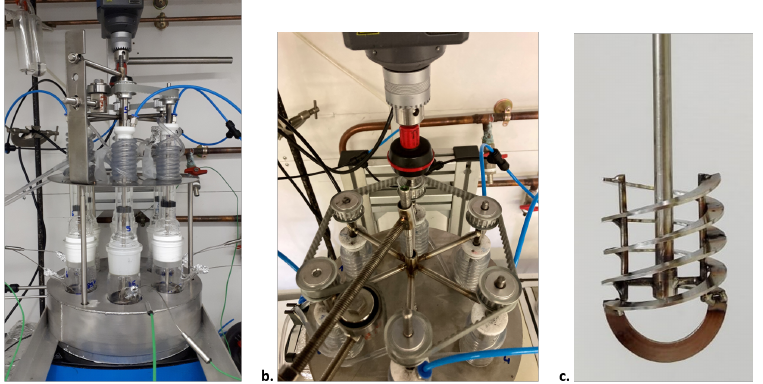
Figure A1. Medium-sized experimental system. ( a ) Whole system. ( b ) Pulleys-belt. ( c ) Mechanical